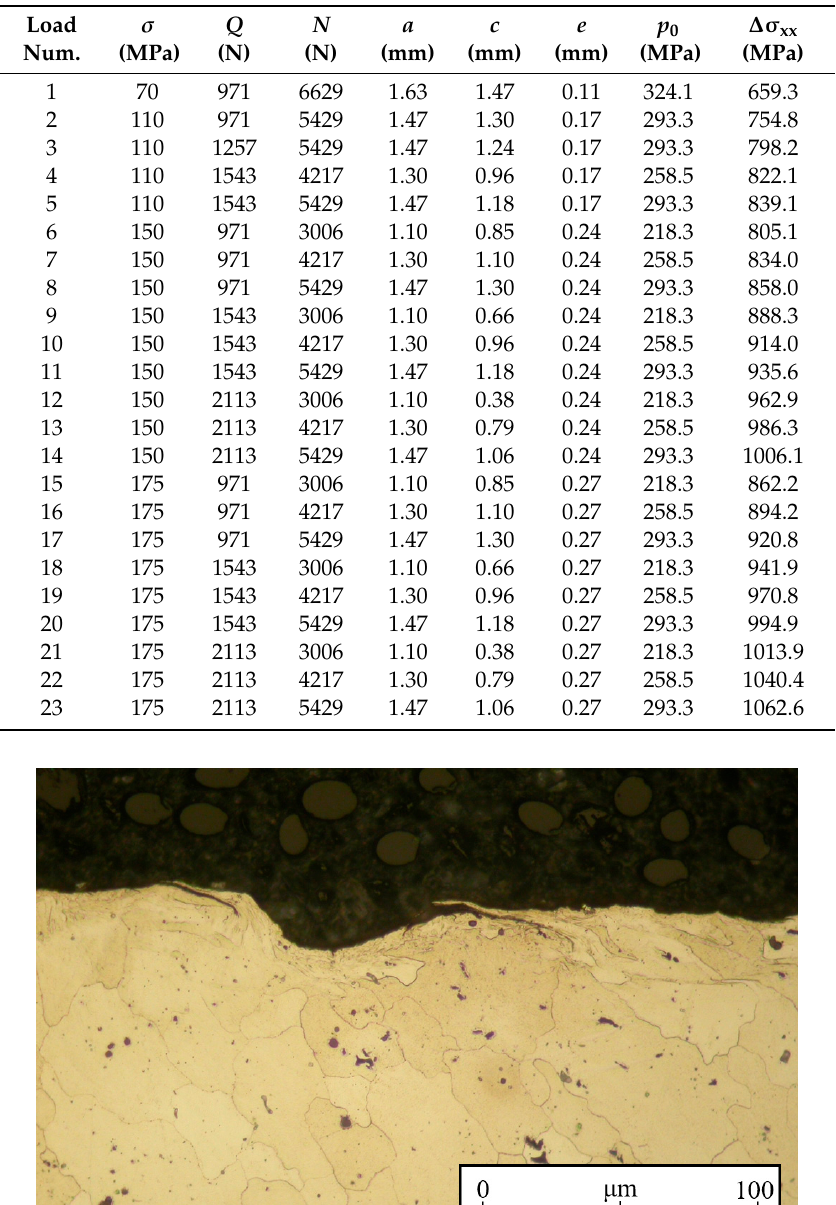
Table 3. Load combinations and related Hertzian parameters.